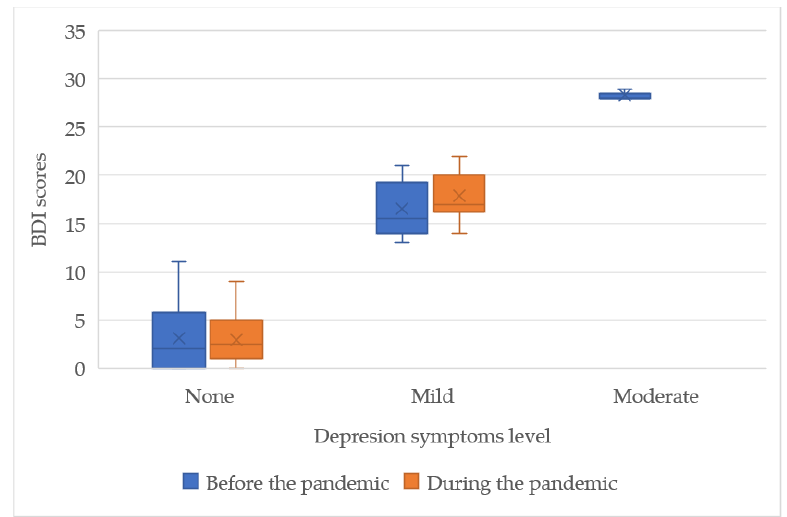
Figure 1. Interquartile range of the BDI scores of the studied groups.